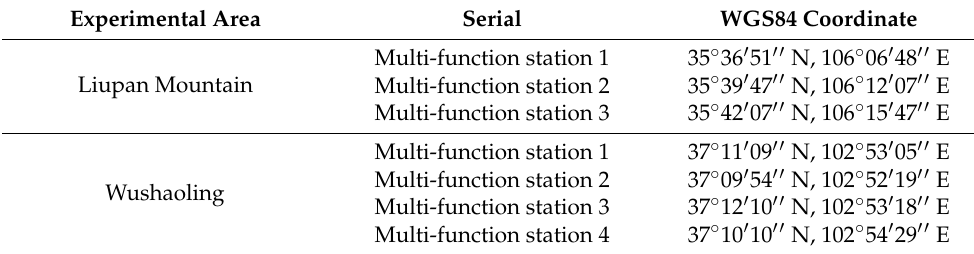
Table 2. Multi-function station